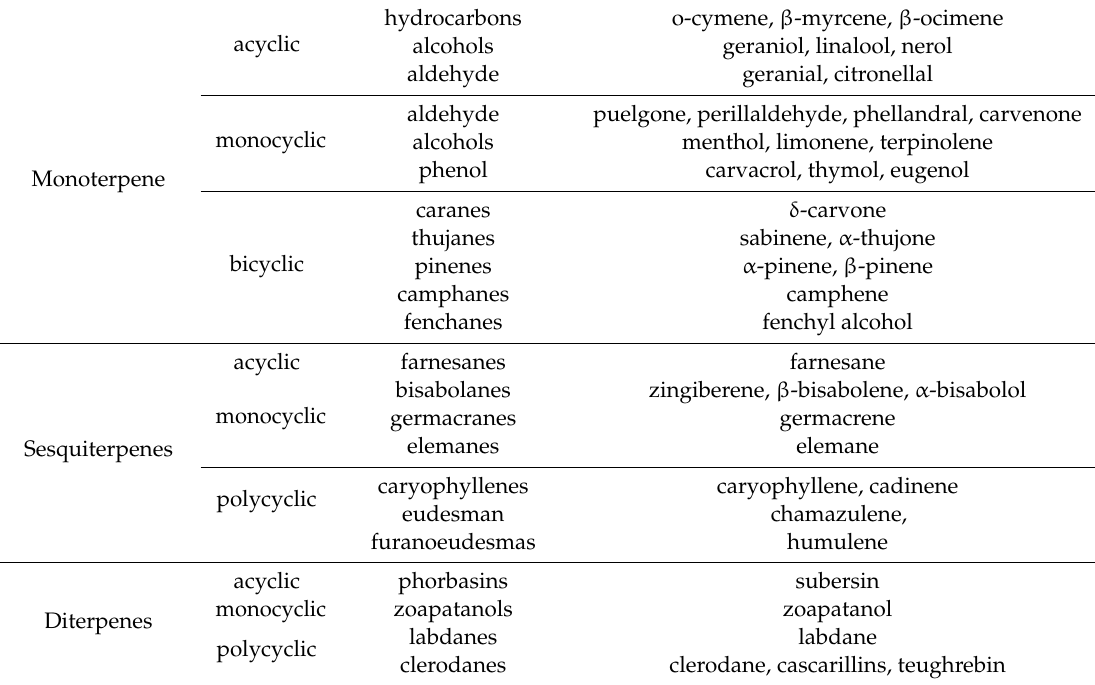
Table 1. Major terpene constituents of essential oils documented in the